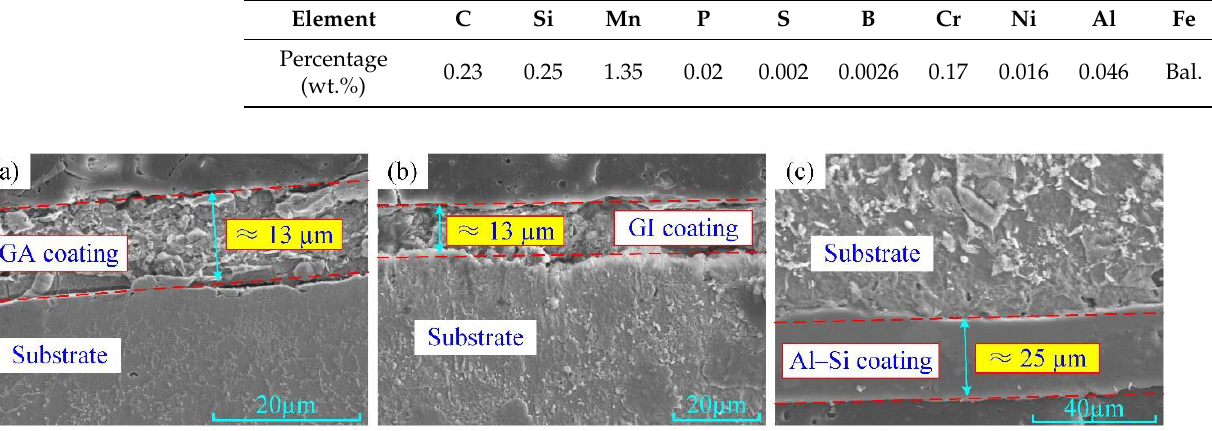
Figure 1. The initial state of galvannealed (GA), galvanized (GI) and Al–Si coatings: ( a ) GA coating; ( b ) GI coating; ( c ) Al–Si coating. Table 1. The chemical compositions of boron steel B1500HS.